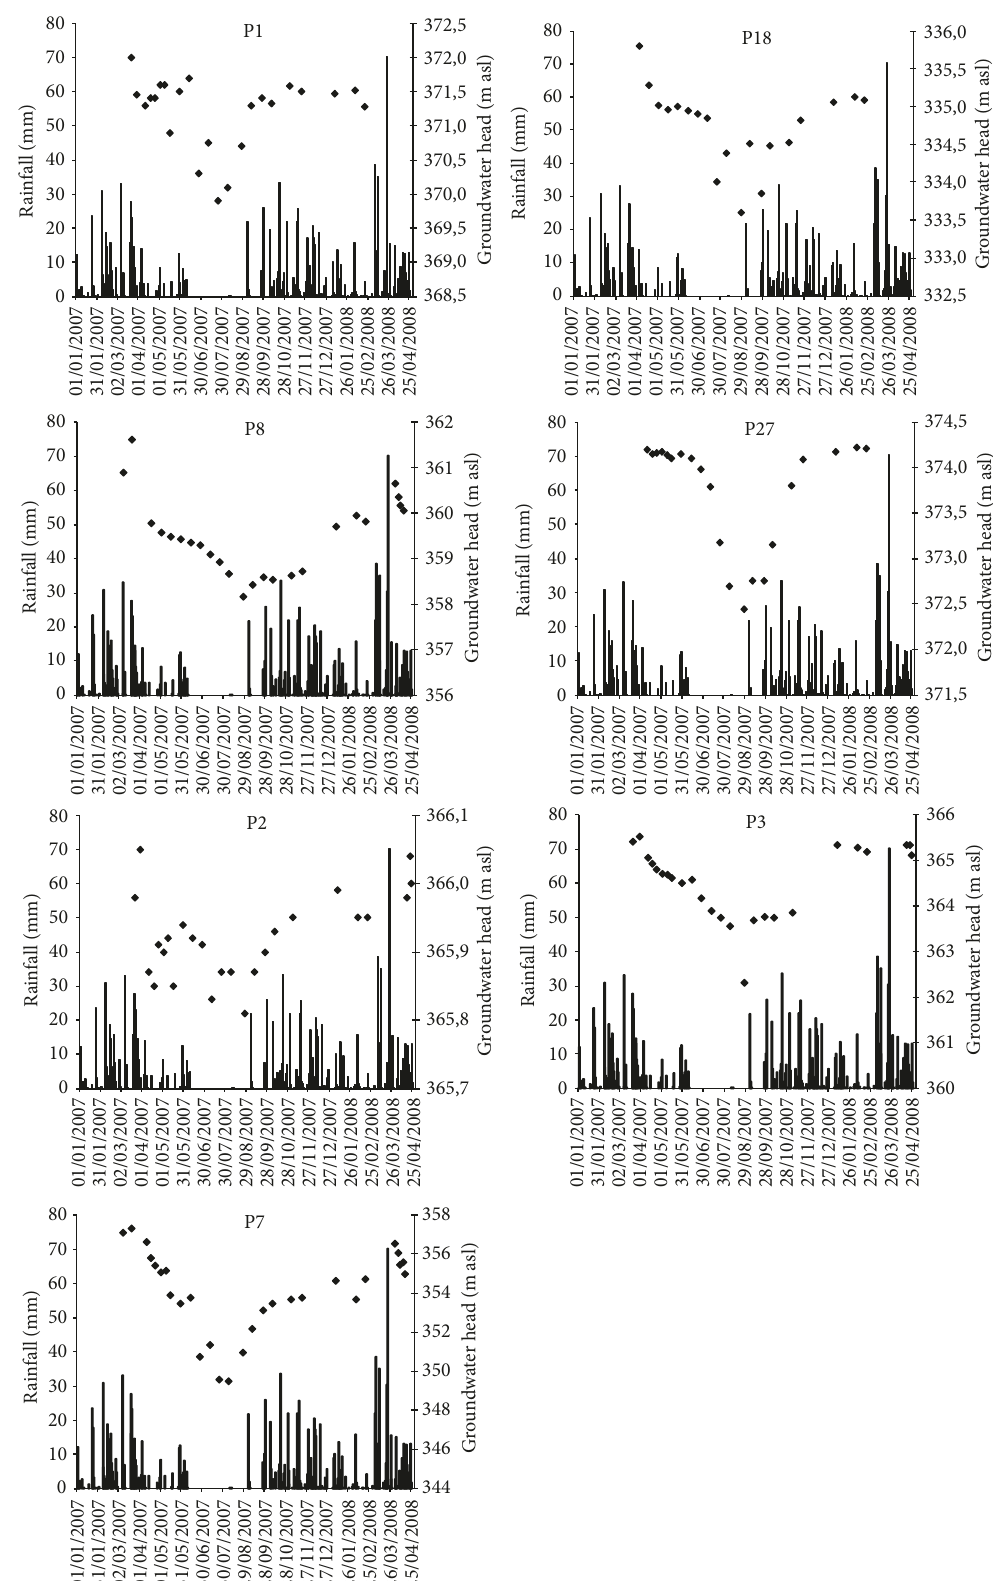
Figure 2: Groundwater head fluctuation in the shallower (P1, P8, P18, P27) and in the deeper wells (P2, P3, P7). The bars represent the daily